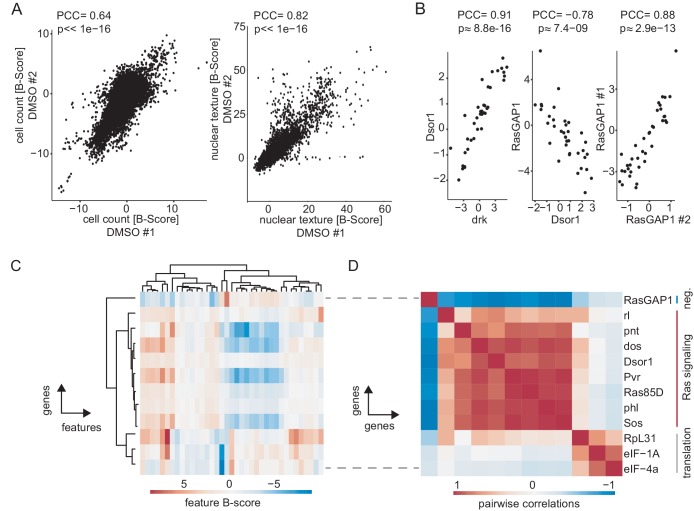
Measuring chemo-genetic interactions by high-throughput imaging and RNAi.(A) Well-level correlation of biological replicates. Shown are B-score normalized cell count data (left, PCC = 0.64) and nuclear texture scores (right, PCC = 0.82) exemplarily for the control condition. One outlier was flagged and not plotted for nuclear texture. (B) Comparison of induced phenotypes by correlation of feature vectors (Pearson correlation coefficient [PCC] and asymptotic p-value). Knockdown of Dsor1 and drk, two known positive regulators of Ras signaling resulted in high (PCC = 0.91) positive correlation. Knockdown of RasGAP1 (neg. regulator of Ras) and Dsor1 induced inverse correlating feature vectors (PCC = −0.78). dsRNA reagents directed against the same gene show a high level of similarity (RasGAP1 design #1 vs. #2, PCC = 0.88). (C) Feature vectors for selected genes regulating Ras signaling and protein translation. Hierarchical clustering groups genes into regulatory units, marked by similar feature profiles. Shown are average B-scores across replicates of 16 representative features. (D) Hierarchical clustered matrix of pairwise correlations. Pairwise PCC were calculated for all example genes in (C). Clustering genes by their pairwise correlation sorted them into groups of functionally related genes. All data show MEK inhibited condition, if not noted otherwise.